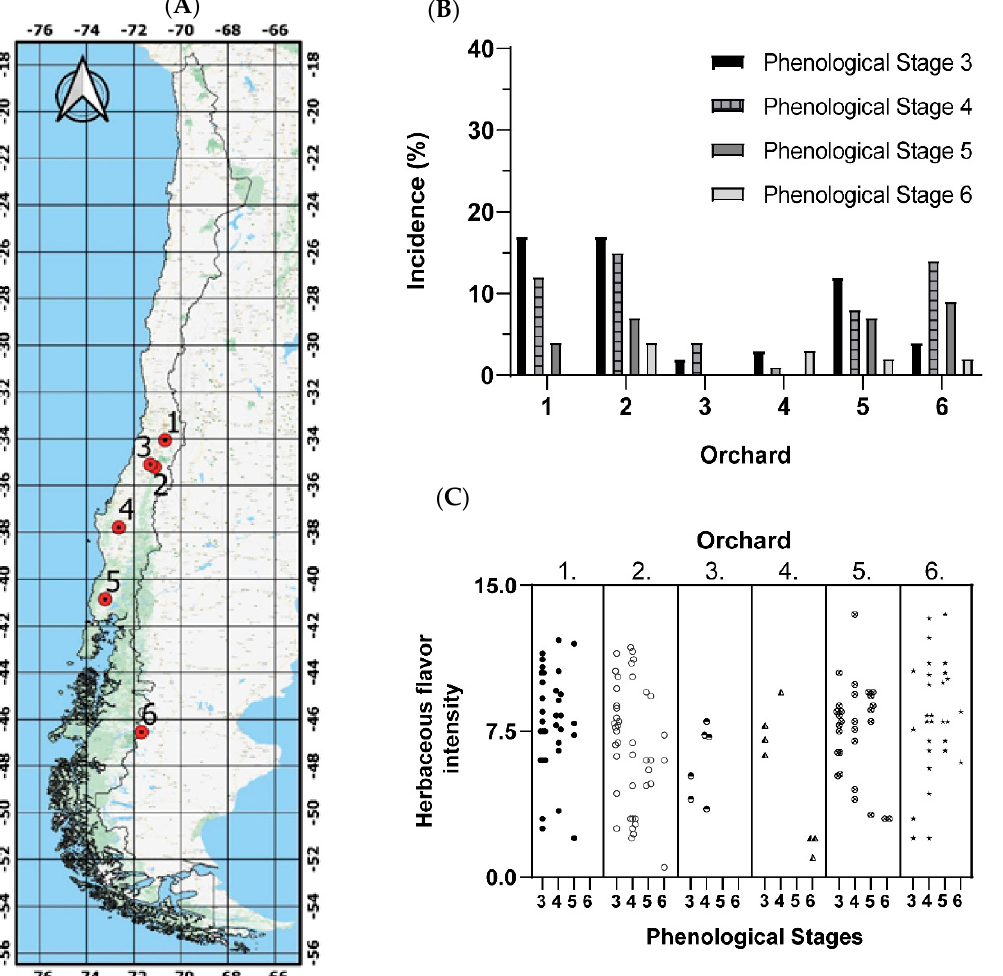
Figure 2. Herbaceous flavor incidence and intensity during fruit development of sweet cherry cv. Regina in orchards 1 to 6 during the 2019/2020 season. ( A ) Geographical distribution of the studied sweet cherry orchards in Chile. ( B ) Herbaceous flavor incidence per orchard. ( C ) Perceived intensity of the herbaceous flavor.